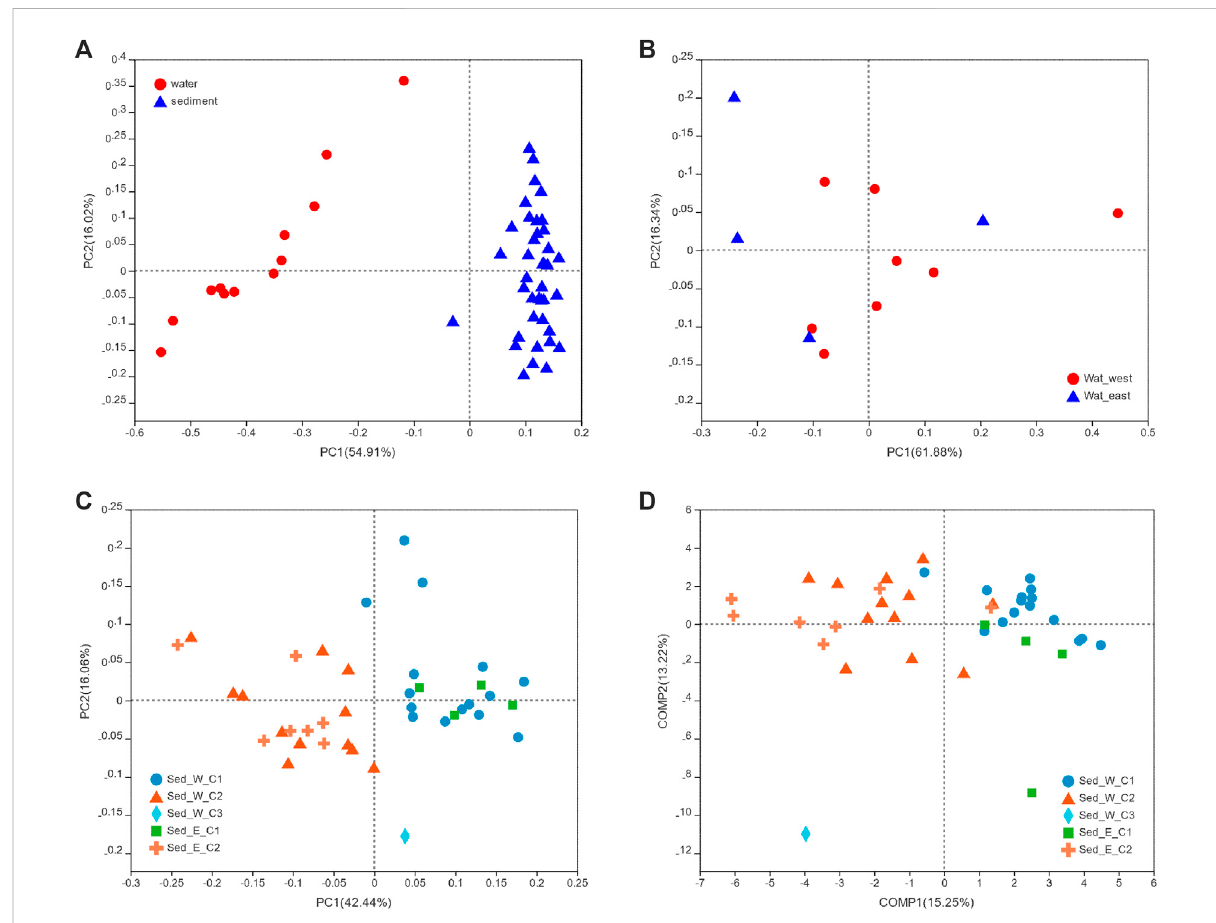
FIGURE 4 PCoA and PLS-DA analyse, in which the Bray -Curtis distance matrix was used for both methods. (A) PCoA analysis to compare water and sedimentsamples, (B) PCoAanalysistocomparewatersamplesfromtheeastandwestdivisionsofthelake,and (C,D) PCoAandPLS-DAanalysesfor the fi ve clusters shown in Figure